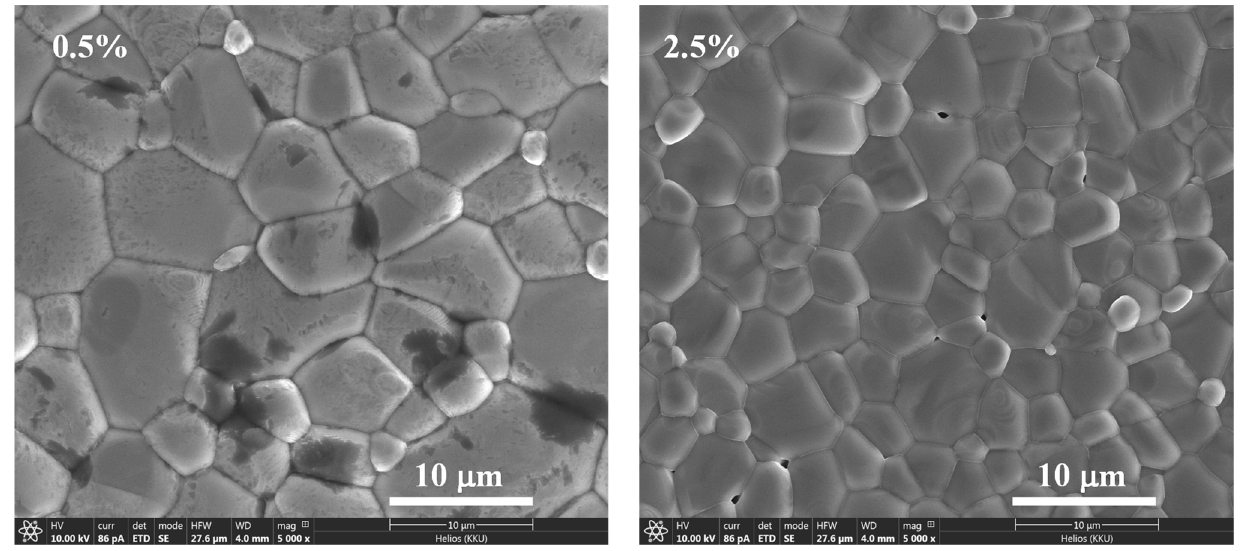
Figure 2. Surface morphologies of the (Zn 0.33 Nb 0.67 ) x Ti 1 − x O 2 ceramics with x = 0.5 and 2.5%.